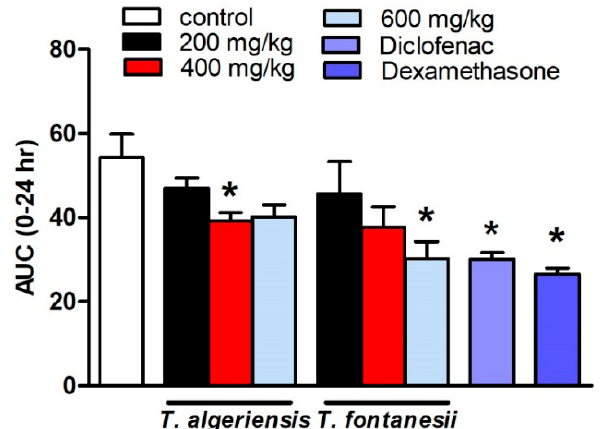
Figure 3. Effect of the pretreatment with T. algeriensis or T. fontanesii (p.o., 200, 400, and 600 mg/kg,), diclofenac (p.o., 20 mg/kg) or dexamethasone (p.o., 2 mg/kg) on carrageenan- (1% suspension, 0.1 mL)-induced hind paw edema in rats. Edema thickness (mm) was measured before and hourly for 5 h and at 24 h following carrageenan injection. Data represents the AUC 0-24 and is presented as the mean ± S.E.M ( n = 5). * p < 0.05 vs. control values by one-way ANOVA followed by Tukey post hoc test.